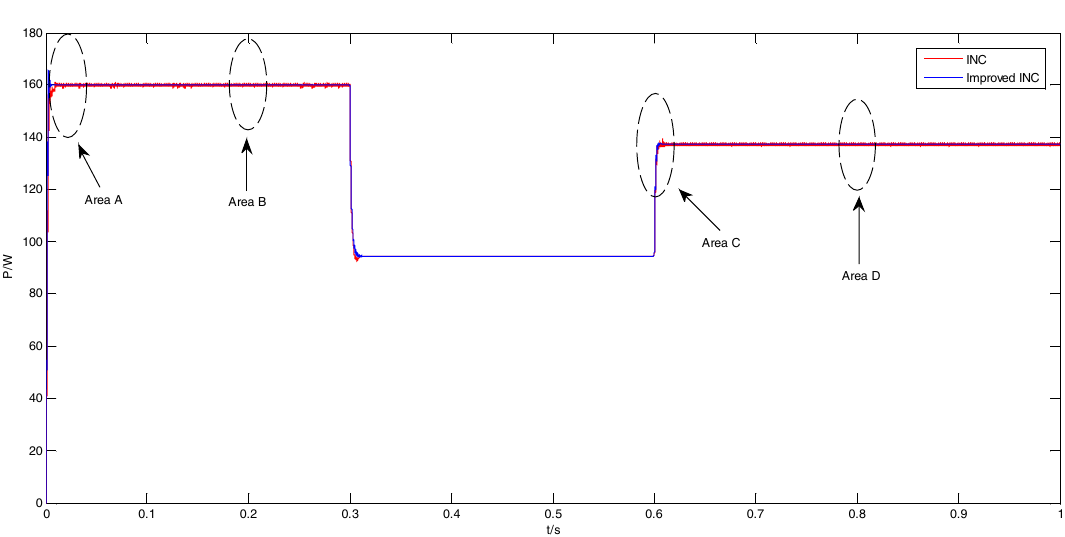
Figure 12. MPPT simulation results of two conductance increment methods.